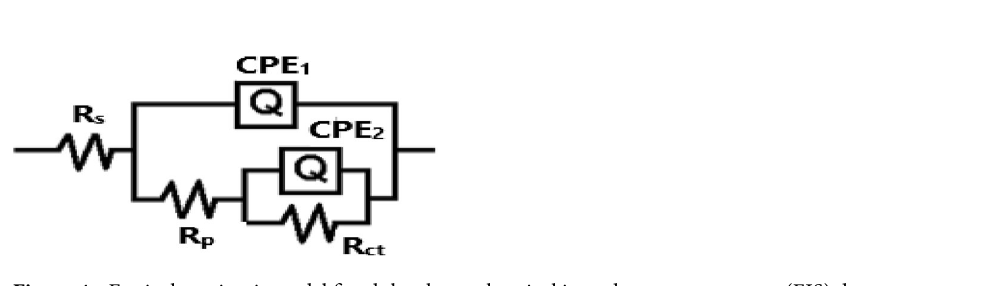
Figure 4. Equivalent circuit model fitted the electrochemical impedance spectroscopy (EIS)